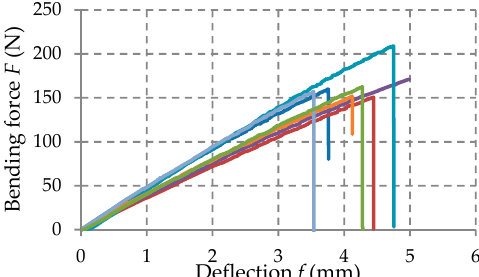
( ) δ− Figure 11. Force–deflection F curves obtained in case of the specimens made of MAT 450 glass fibers/polyester resin. ( ) δ− Figure 12. Force–deflection ( F − δ ) curves obtained in case of the specimens made of chopped glass Figure 12. Force–deflection F curves obtained in case of the specimens made of fibers/polyester chopped glass fibers/polyester resin. Table 4. Properties of materials corresponding to each layer of the manhole cover structure. Material Tested